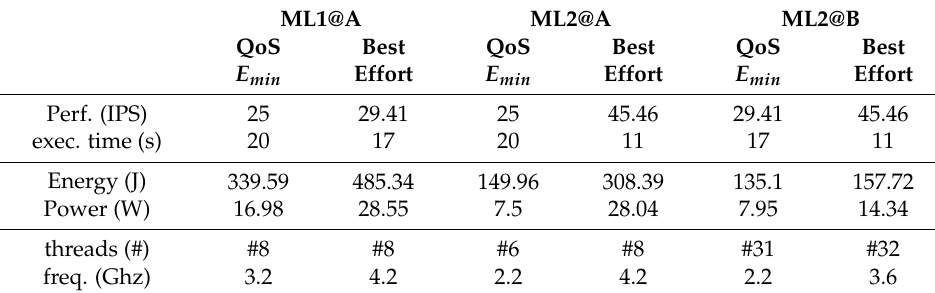
Table 5. ML—QoS_ E min X Best Effort.